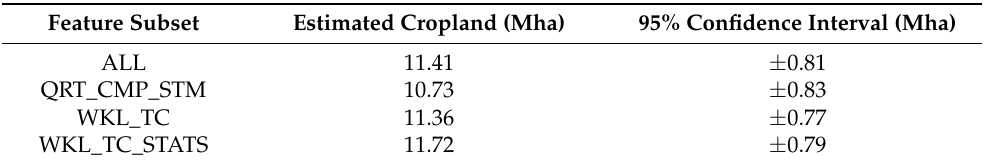
Table 4. Error-adjusted cropland area estimates for Turkey in 2015. See Table 2 for abbreviations of model